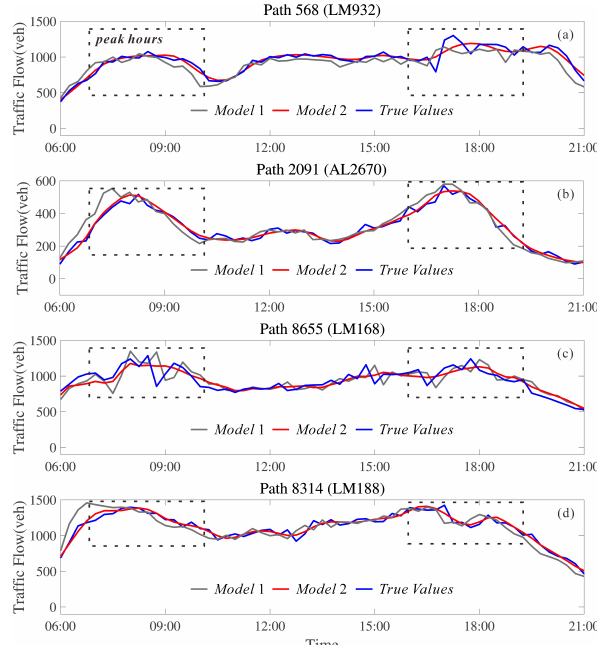
Figure2. Thisisafigure,Schemesfollowthesameformatting. Iftherearemultiplepanels,theyshould Figure 12. Tra ffi c flow forecasting results on Thursday of: ( a ) path 568(LM932); ( b ) path 2091(AL2670); belistedas: ( a )Descriptionofwhatiscontainedinthefirstpanel. ( b )Descriptionofwhatiscontained inthesecondpanel. Figuresshouldbeplacedinthemaintextneartothefirsttimetheyarecited. A ( c ) path 8655(LM168); ( d ) path 8314 captiononasinglelineshouldbecentered.